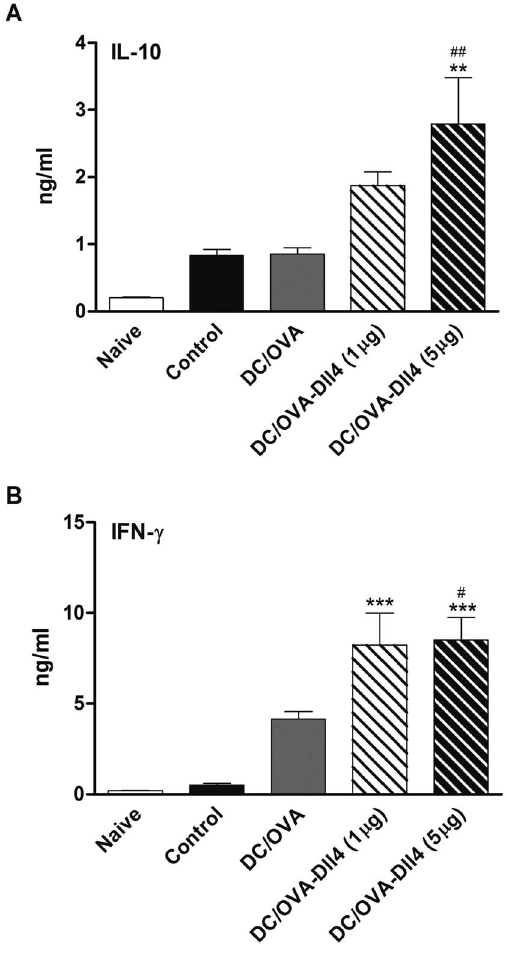
Figure 8. Levels of interleukin-10 and interferon- c increase in mice receiving Dll4-modulated dendritic cells. Splenocytes (3 6 10 6 cells/mL) from all groups of mice were stimulated with 100 m g/mL ovalbumin (OVA) in 24-well plates, and culture supernatants were collected after 5 d of culture. Levels of cytokine production of interleukin (IL)-10 and interferon (IFN)- c were analyzed using ELISA. Results are expressed as the mean 6 SEM of 5 to 7 mice per group. ** p , 0.01, *** p , 0.001 compared to the positive control group (control). # p , 0.05, ## p , 0.01 compared to the DC/OVA group.